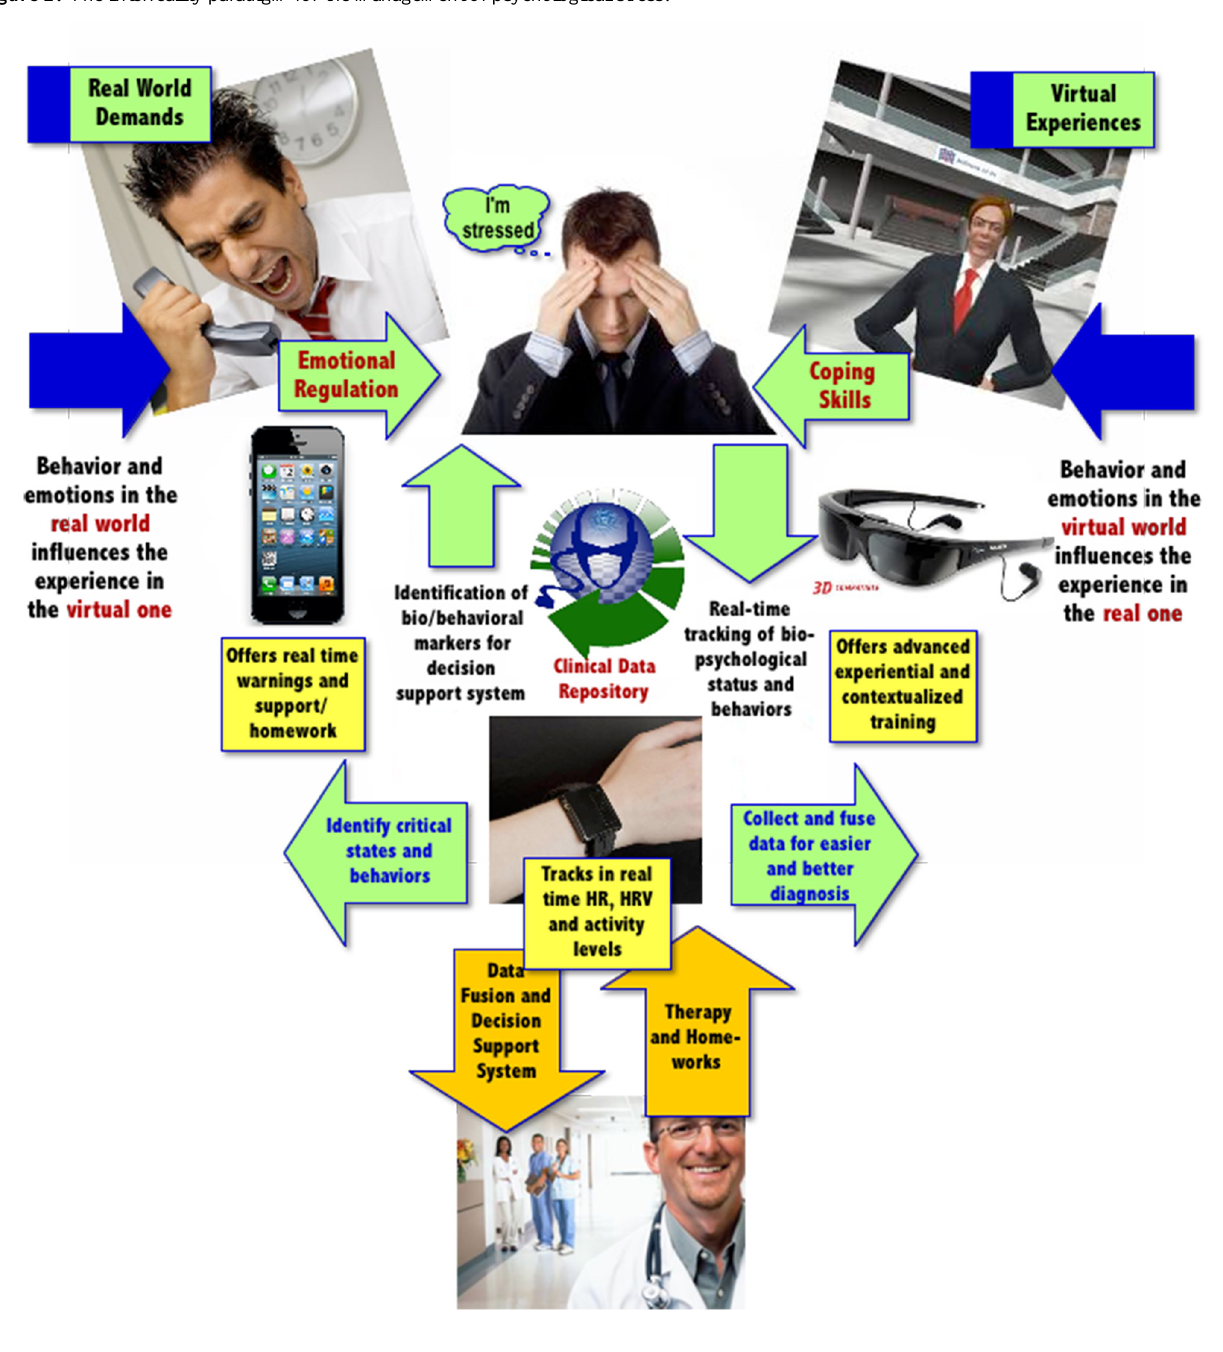
Figure 2. The Interreality paradigm for the management of psychological